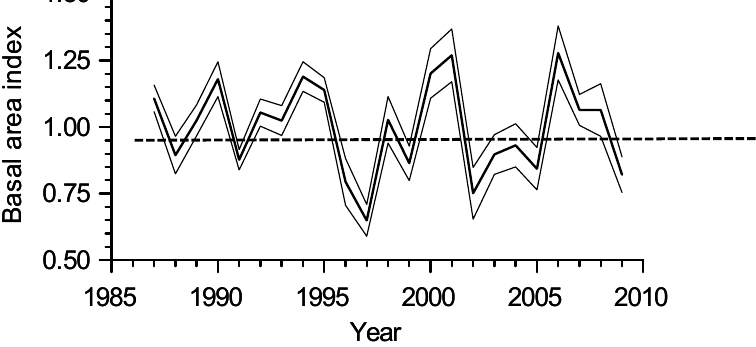
Figure 2. Basal area index (BAI) growth chronology of all 18 full-sib families of hybrid aspen ( Populus × smithii ) combined (bold line) and the lower and upper limits of a 95% confidence interval of the mean (thin lines).